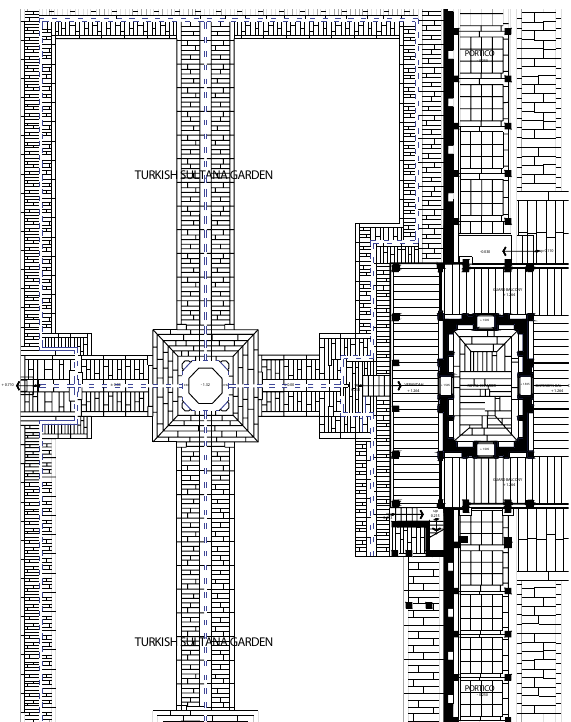
fig. 4. The Turkish Sultana Gardens are garden adjacent to the Turkish Sultana House and a variant of the Charbagh with its classical four quadrants. The above is a measured drawing showing (a) the water tank with four narrow channels intersection, (b) cooling devices in front of Imperial Pavilion, and (c) plan indicating water channels (KaED IIuM Heritage Centre 2005)